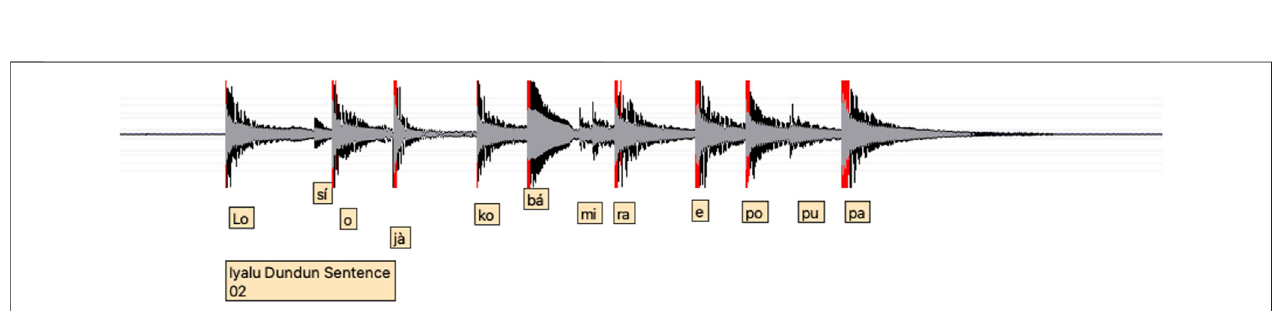
FIGURE 4 | Ìyáàlù dùndún amplitude wave for the sentence “ Lo sí ojà k ’ o bámi ra epo pupa ” ( “ Go to the market and buy me palm oil ”